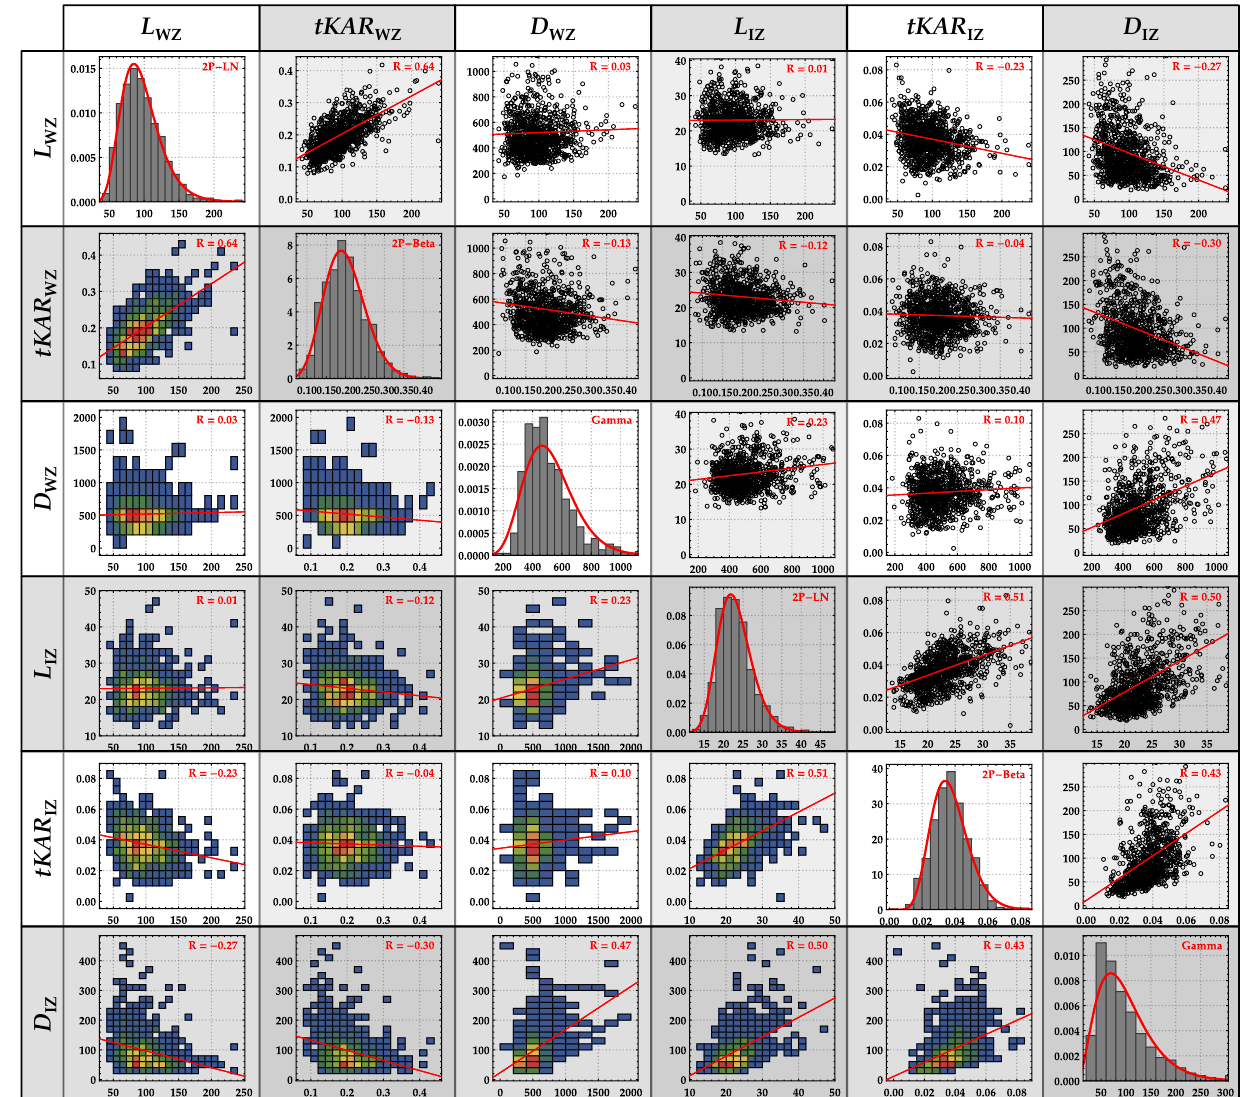
Figure 6. Simplified linear regressions and correlations together with histograms and corresponding density functions of assumed statistical distribution models of global (mean) board properties X = { L WZ ; L IZ ; D WZ ; D IZ ; tKAR WZ ; tKAR IZ } of all boards in the databases.